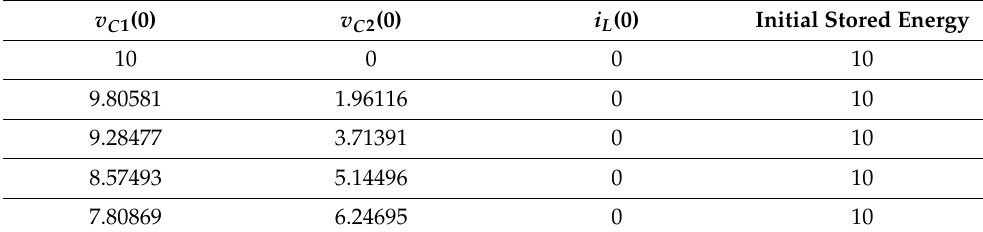
Table 3. Parameters of simulation in Figure